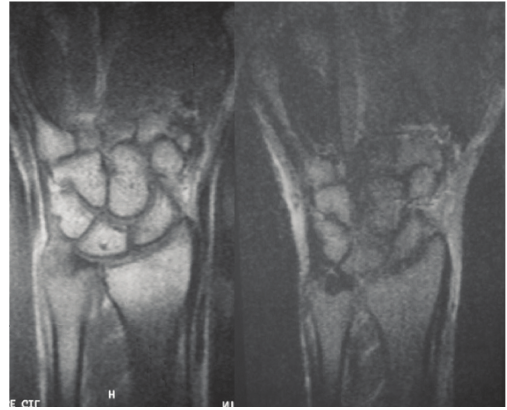
Figure 2: Wrist magnetic resonance scan where the T2-weighted sequence revealed a high-hyperintense signal in area of the tri- angular fibrocartilage and synovium. It did not demonstrate the characteristic nidus of osteoid osteoma.